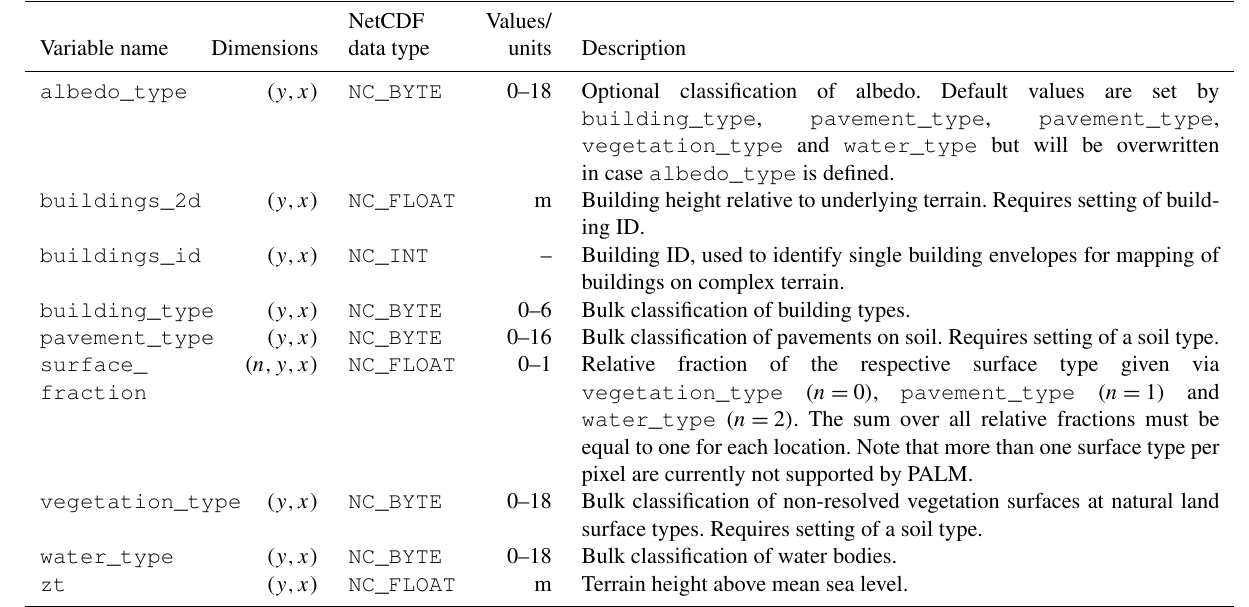
Table 1. List of LOD1 variables that can be specified in the static driver